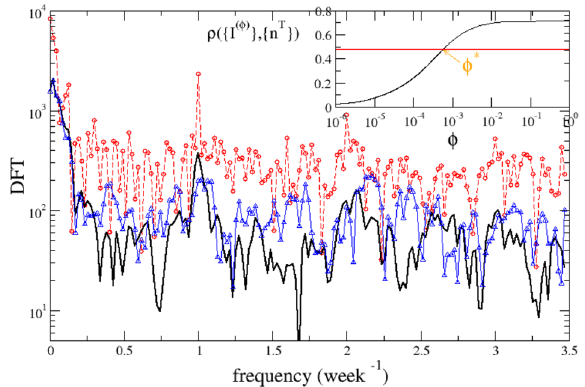
I n T (black lines), (red circles) and { } { } , I (φ) n T as function of φ . The horizontal red line represent the value { } { } (cid:31) (cid:30)